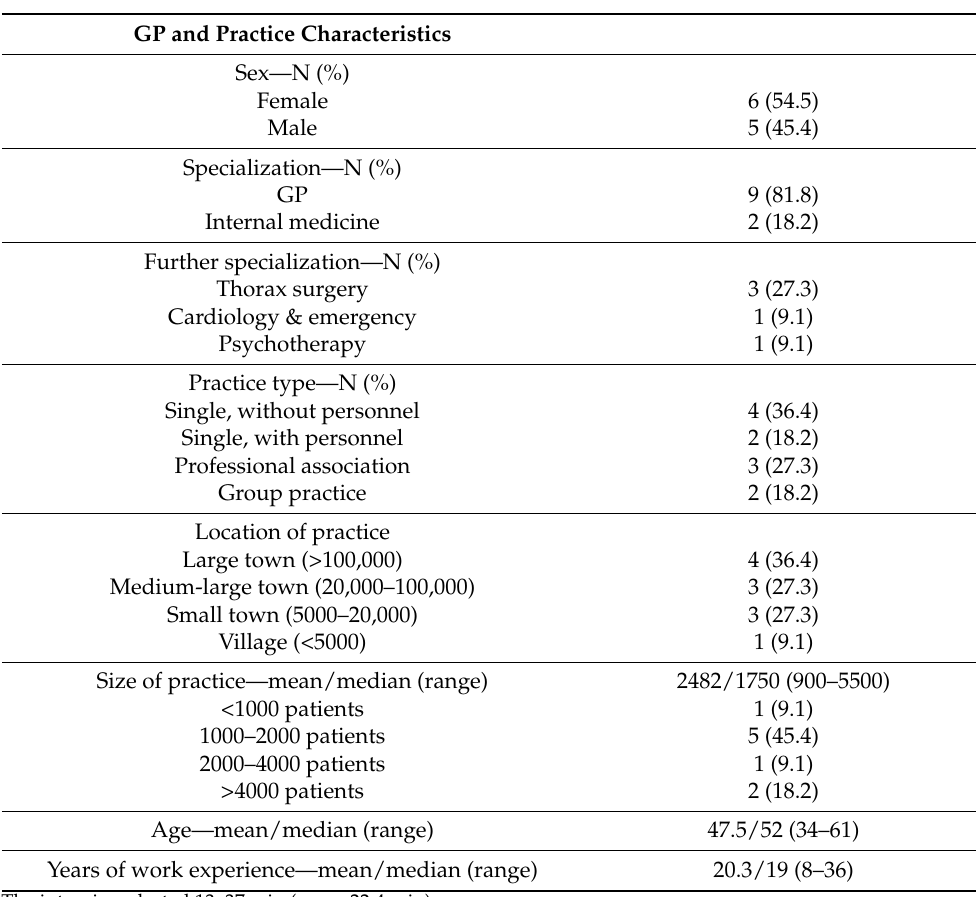
Table 1. Characteristics of participating GPs and